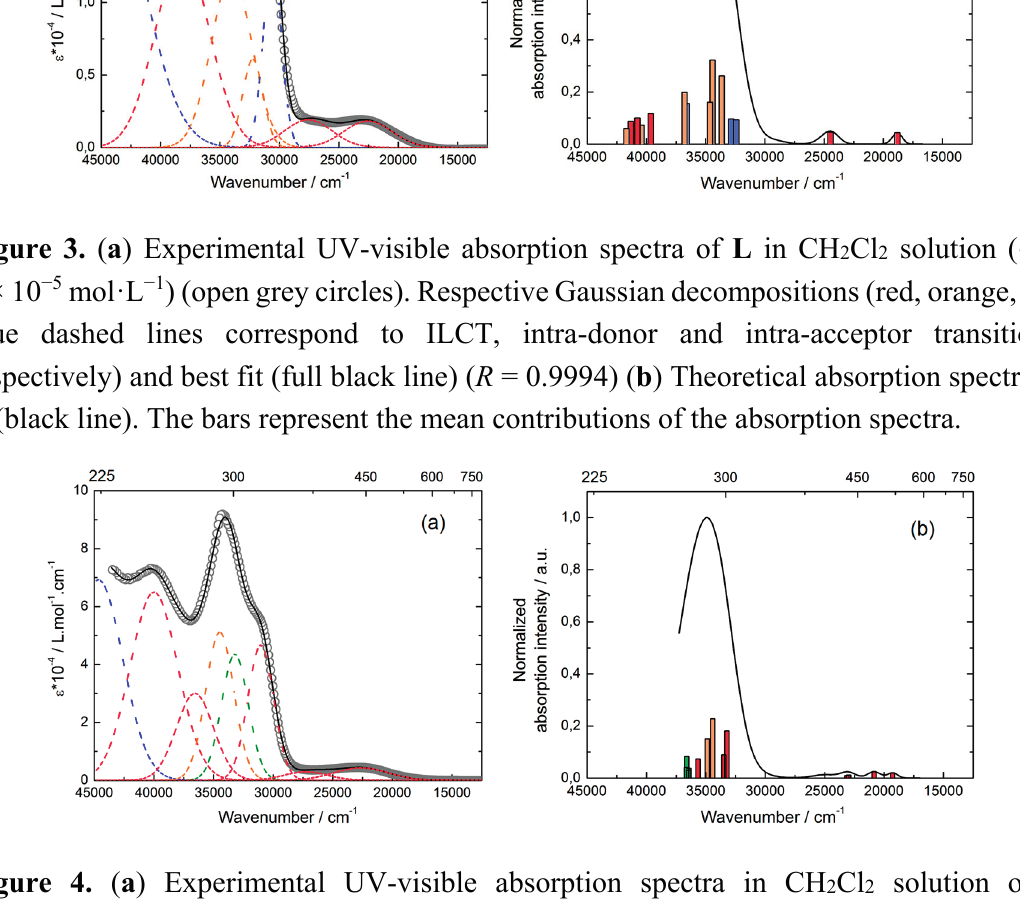
Figure 4. ( a ) Experimental UV-visible absorption spectra in CH 2 Cl 2 solution of 2 ( C = 4 × 10 − 5 mol·L − 1 ) (open grey circles). Respective Gaussian decompositions (green dashed line corresponds to intra-hfac transitions) and best fit (full black line) ( R = 0.9998); ( b ) Theoretical absorption spectra of the Y III analogue (black line). The bars represent the mean contributions of the absorption